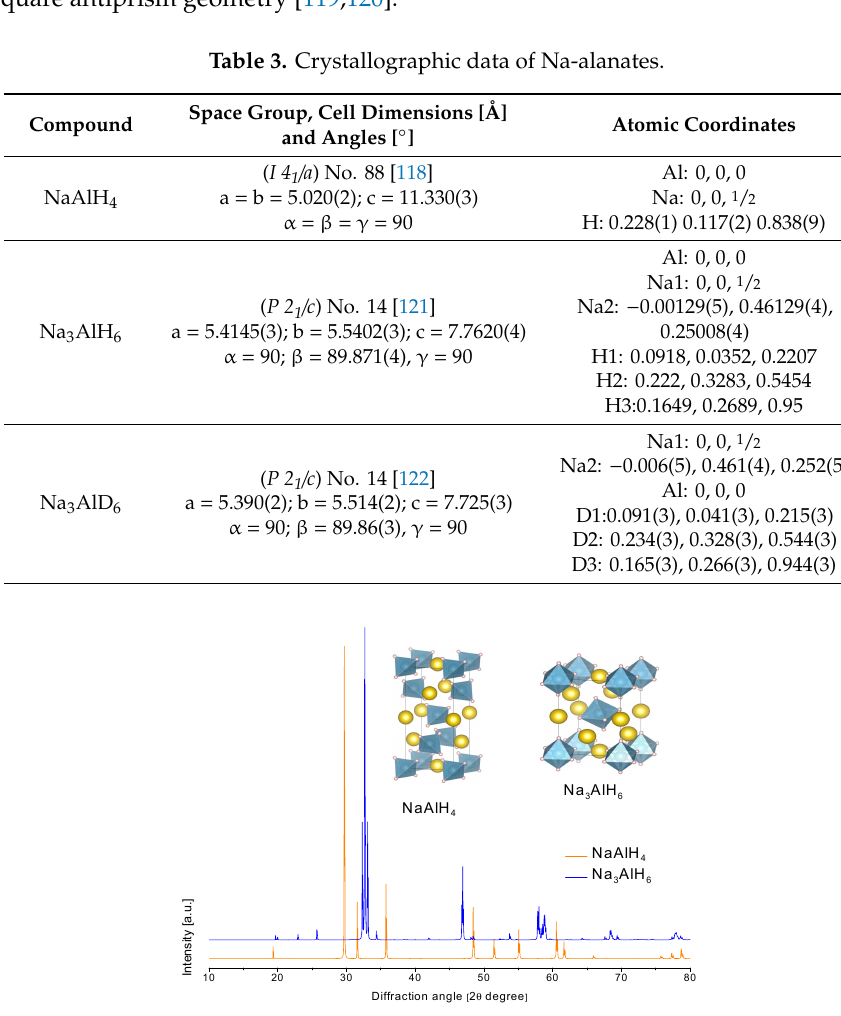
Figure 7. Crystal structure of sodium alanates and their calculated diffraction patterns ( λ = Cu k α 1 ). The NaAlH 4 and Na 3 AlH 6 dehydrogenation enthalpies are well known (37 and 47 kJ/mol H 2 , respectively, Ti-doped) [88]. These values mainly indicate a kinetic restrain for